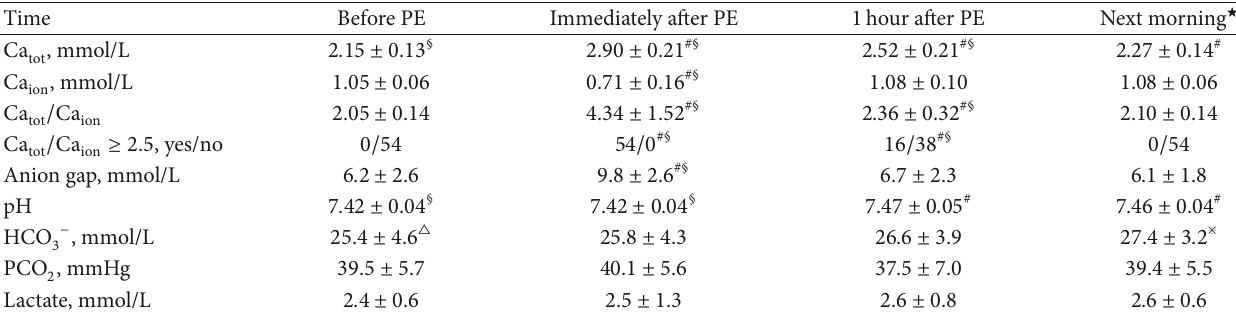
Table 4: Calcium and acid-base status during and after ALSS therapy.